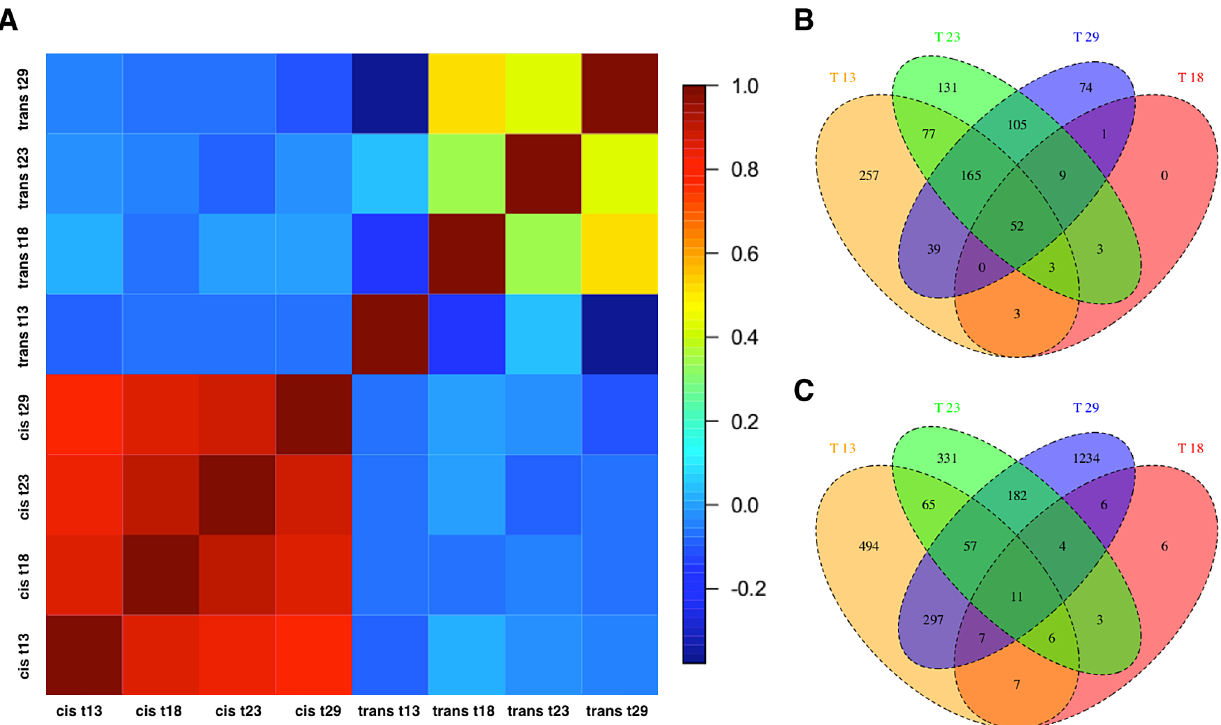
Fig 4. Temperature dependence of cis - and trans -regulatory differences. (a) Pairwise correlation coefficient matrix (Spearman ’ s r ) between cis -effects and trans -effects across all temperatures. The correlation of cis -effects across environments was more similar than the one of trans-effects. (b) Venn Diagram showing the number of cis -regulated and (c) trans -regulated genes at four different